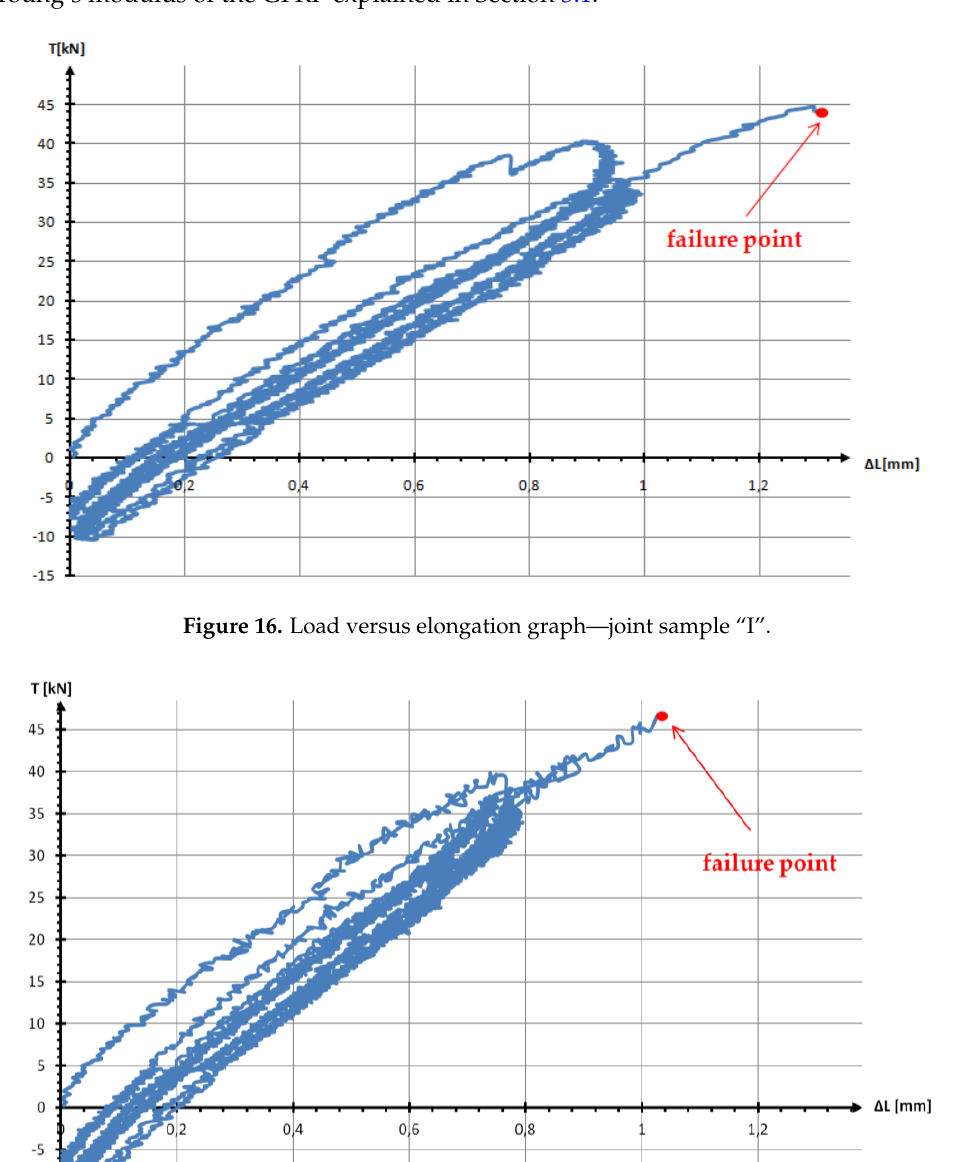
Figure 18. Strain gauges location and equilibrium scheme (unit length: mm). Table 9. Strain and axial force gradients—joint sample “I”. Position